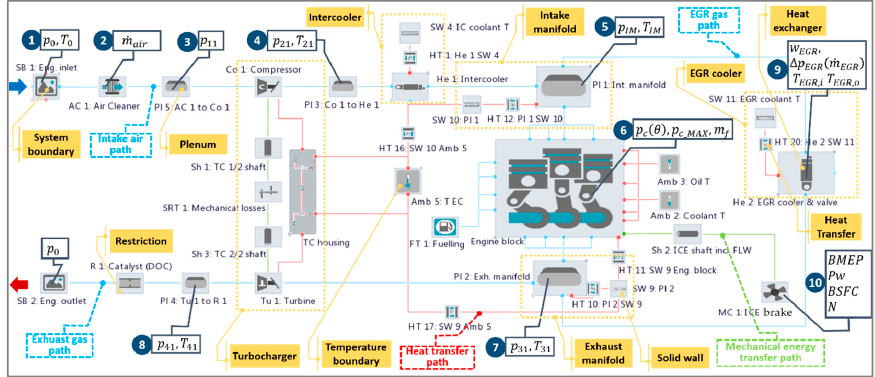
Figure 1. Elements, components (group of elements) of the ICESM and typical set of measurement data in standard measurement investigations of turbocharged engines in labeled positions 1, 2, …, 10 with dark blue circles used for the ICESM calibration.